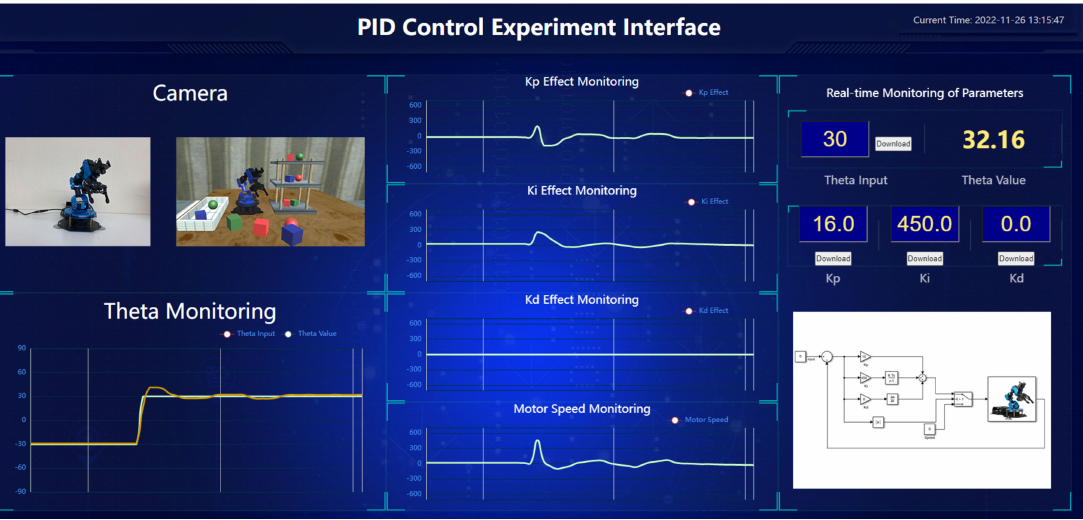
Figure 15. Experimental result with PI